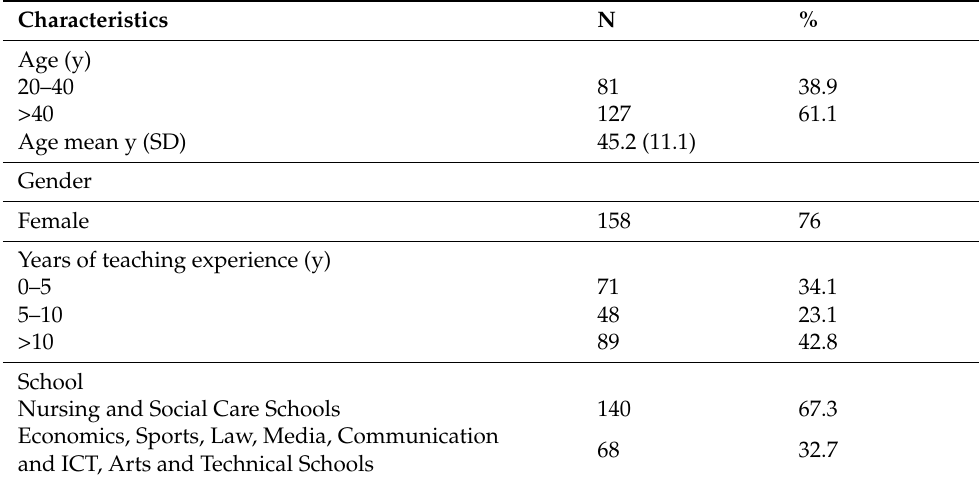
Table 1. Background characteristics of the lecturers participating in the survey (N =